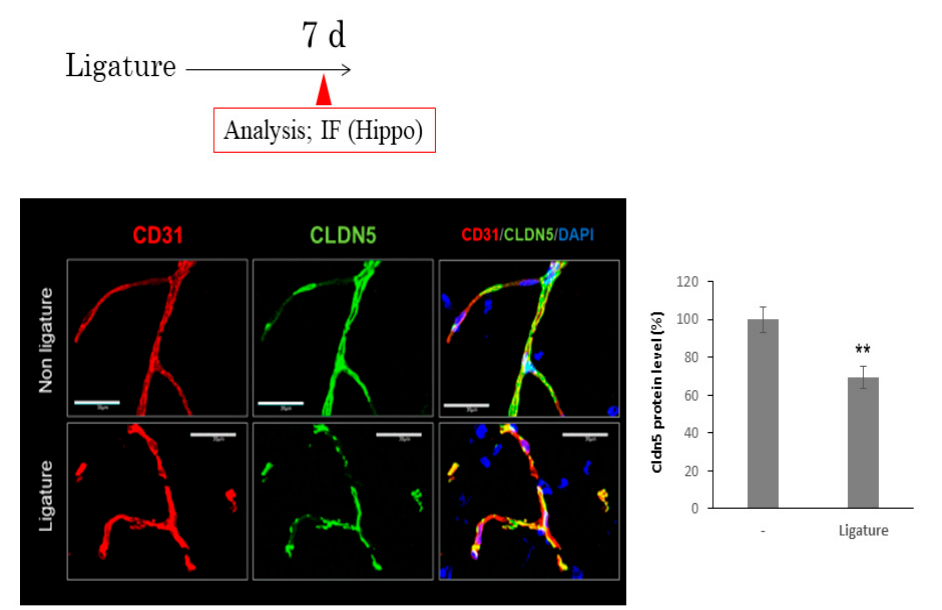
Figure 4. The effect of ligature-induced PD on the levels of claudin 5 on blood vessels in the hippocampus. One week after ligation, the hippocampus was collected. Representative image of claudin 5 (green) is shown along the vessel labeled with endothelial marker (CD31). Blue shows nuclear. Bar = 30 μ m. Bar graph shows the ratio area of claudin 5 expression in the vessel. (mean ± SE, n = 10/group). ** p < 0.01. Significantly different from the control, Student’s t- test.